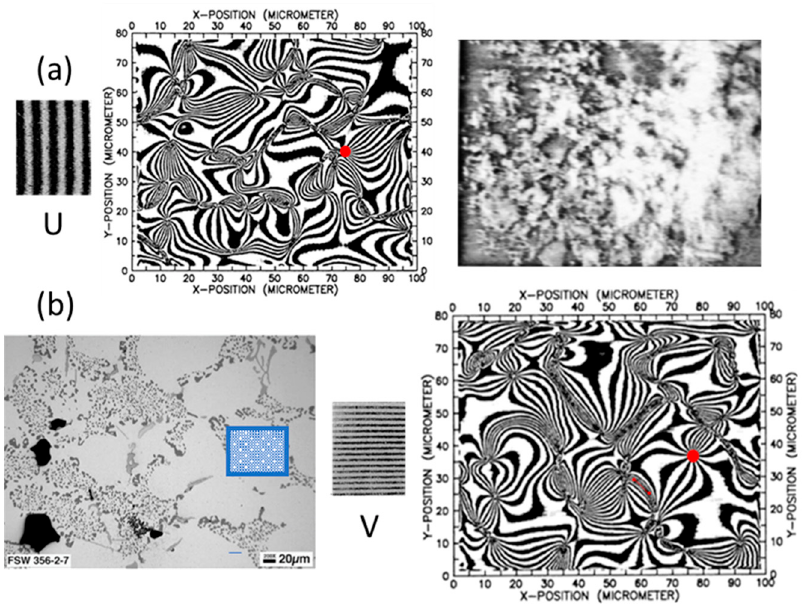
Figure 11. ( a ) Moiré U and V patterns of an 100 × 80 μ m 2 area of a tensile Al–SiC composite specimen with an aluminum matrix reinforced by SiC particles. Corresponding U and V patterns in the mm scale and microphotography of the observed region, black areas SiC particles, bright areas aluminum matrix; ( b ) Metallographic image of the aluminum matrix and the observed region of 100 × 80 μ m 2 . The observed region is smaller than the average grain size. Reprinted from [14] with permission from Elsevier.